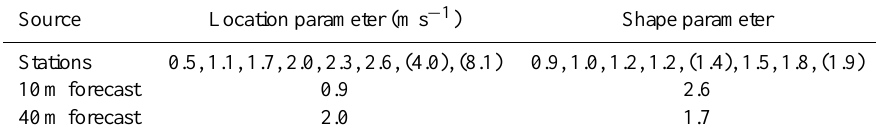
Table 1. Weibull distribution parameters fitted to station and forecast wind speeds (ridgetop station values in